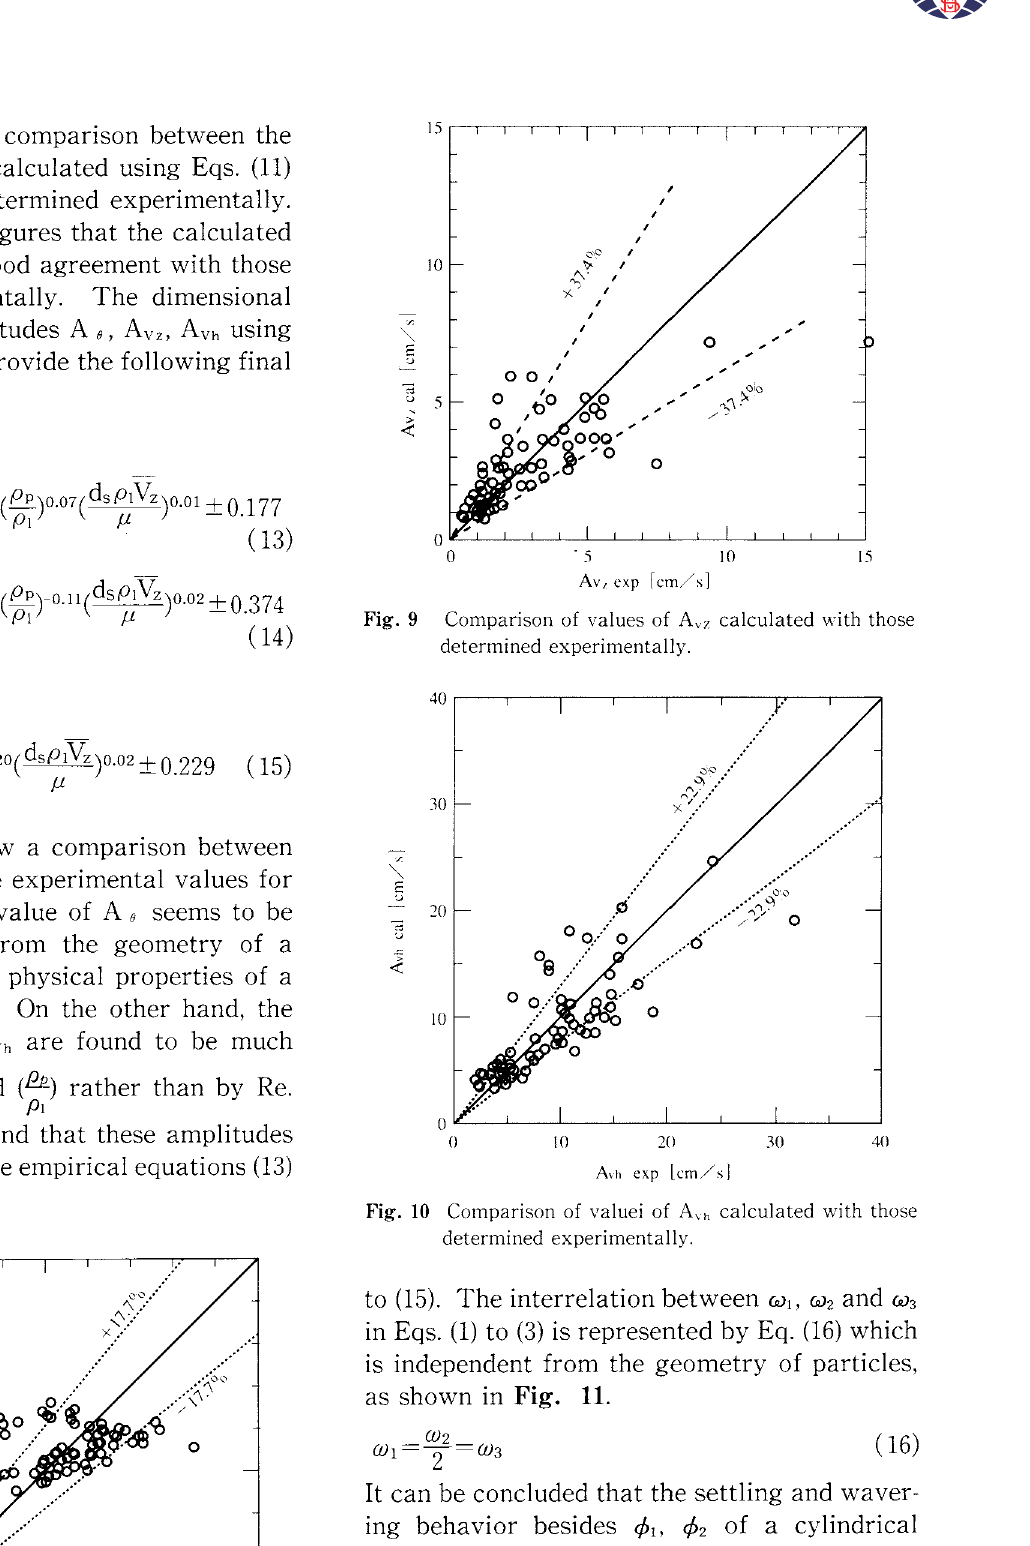
Fig. 8 Comparison of values of A e calculated with those determind experimentally.